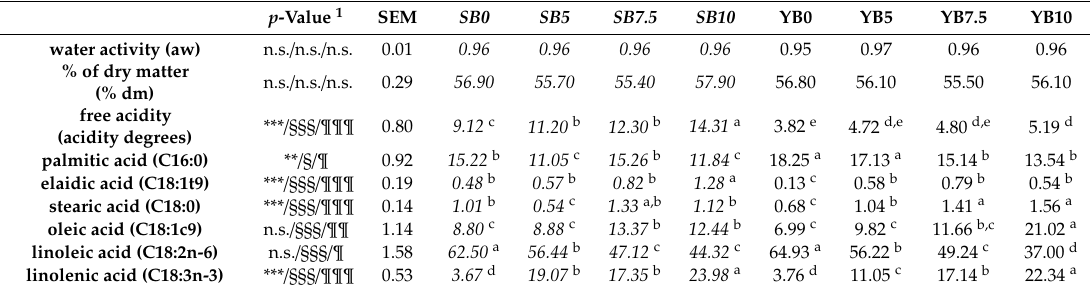
Table 3. Water activity (aw), dry matter (dm %), free acidity, and most representative fatty acids (relative %) of cooked breads. Data presented are the mean of three replicates. Data reported in italics were already published in Sanmartin et al., 2020